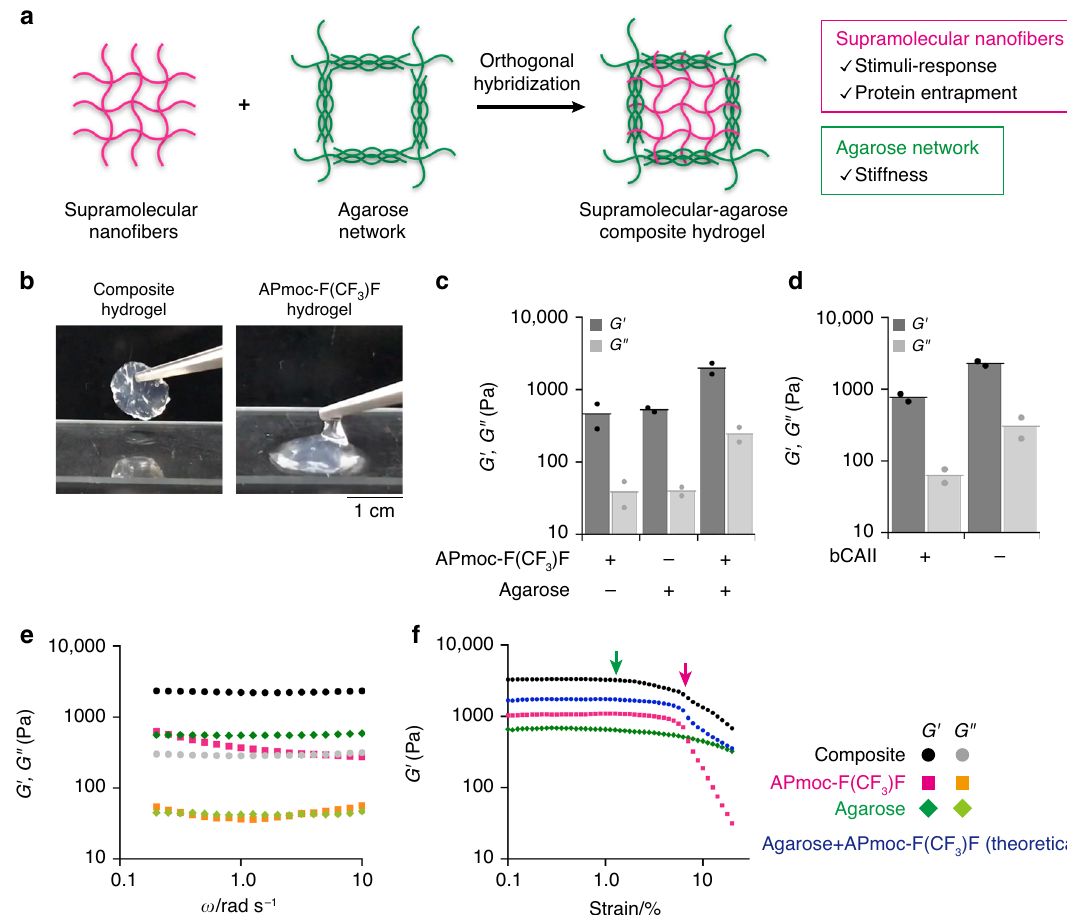
Fig. 3 Rheological analysis of a supramolecular – agarose composite hydrogel. a Schematic illustration of orthogonal hybridization of supramolecular APmoc-F(CF 3 )F hydrogel and agarose gel. b Photographs of (left) the composite hydrogel and (right) the APmoc-F(CF 3 )F hydrogel. c Rheological properties of (left) APmoc-F(CF 3 )F , (middle) agarose, and (right) composite hydrogels. The data represent the mean ( n = 2). d Rheological properties of the composite hydrogel after addition of (left) bCAII and (right) buffer lacking bCAII. Sweep rate: 0.2 rad/s, strain: 1%. e Frequency sweep rheological properties of the (magenta) APmoc-F(CF 3 )F , (green) agarose, and (black) composite hydrogels. Strain amplitude: 1%. f G ′ values of (magenta) APmoc-F (CF 3 )F , (green) agarose, (black) composite gels, and (blue) the sum of APmoc-F(CF 3 )F and agarose. Green and magenta arrows indicate the limit points of the linear viscoelastic region of agarose and APmoc-F(CF 3 )F . The G ′ value of the composite hydrogel changed in two steps around the green and magenta arrows. Frequency: 10 rad/s. G ′ : storage shear modulus, G ′ : loss shear modulus. Condition: [ APmoc-F(CF 3 )F ] = 0.6 wt%, [agarose] = 0.5 wt%, [bCAII] = 30 µ M, 8 h,